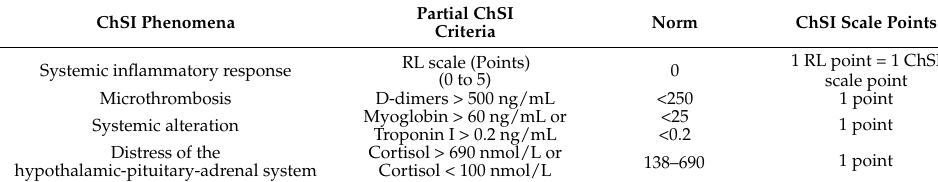
Table 4. The Chronic Systemic Inflammation (ChSI)